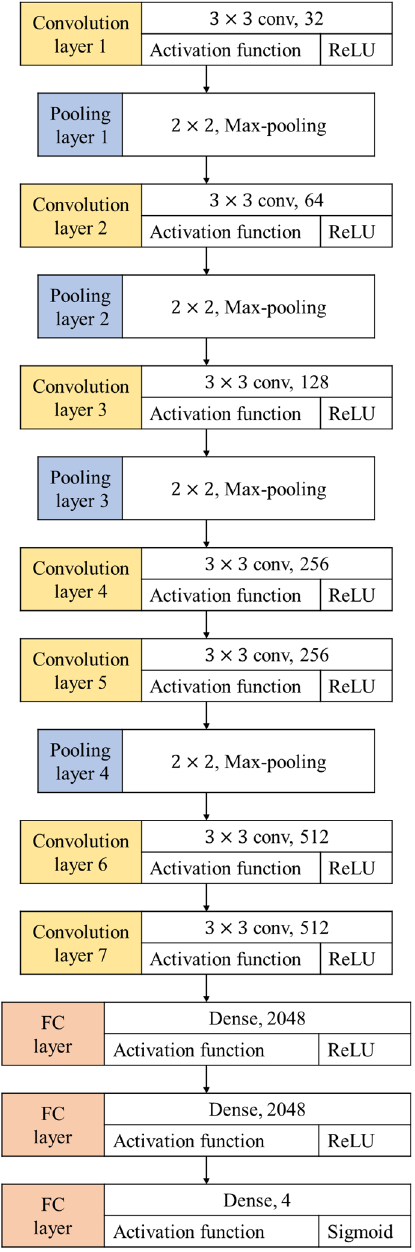
Figure 5. Architecture of the convolution neural network.